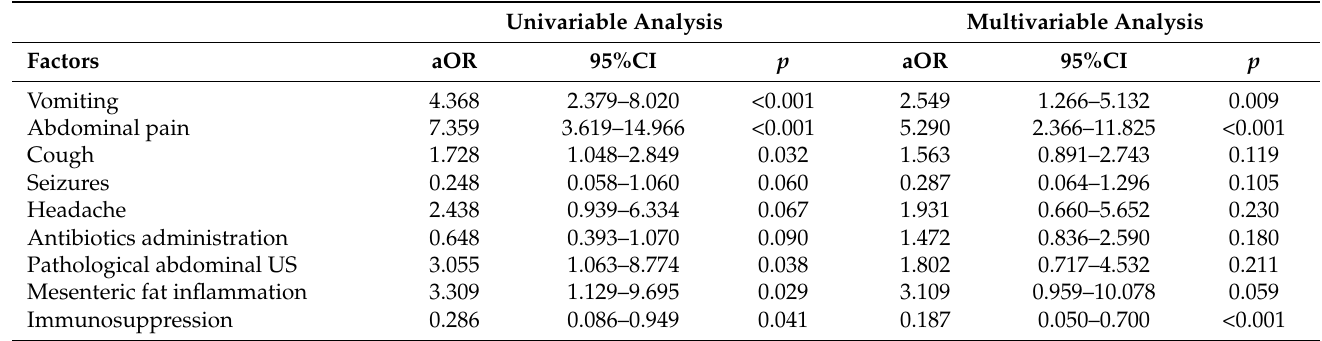
Table 4. Factors associated with the occurrence of diarrhea in univariable and multivariable analysis. Variables found to have p < 0.10 at univariable analysis (see Supplementary Table S4) were included in multivariable analysis.